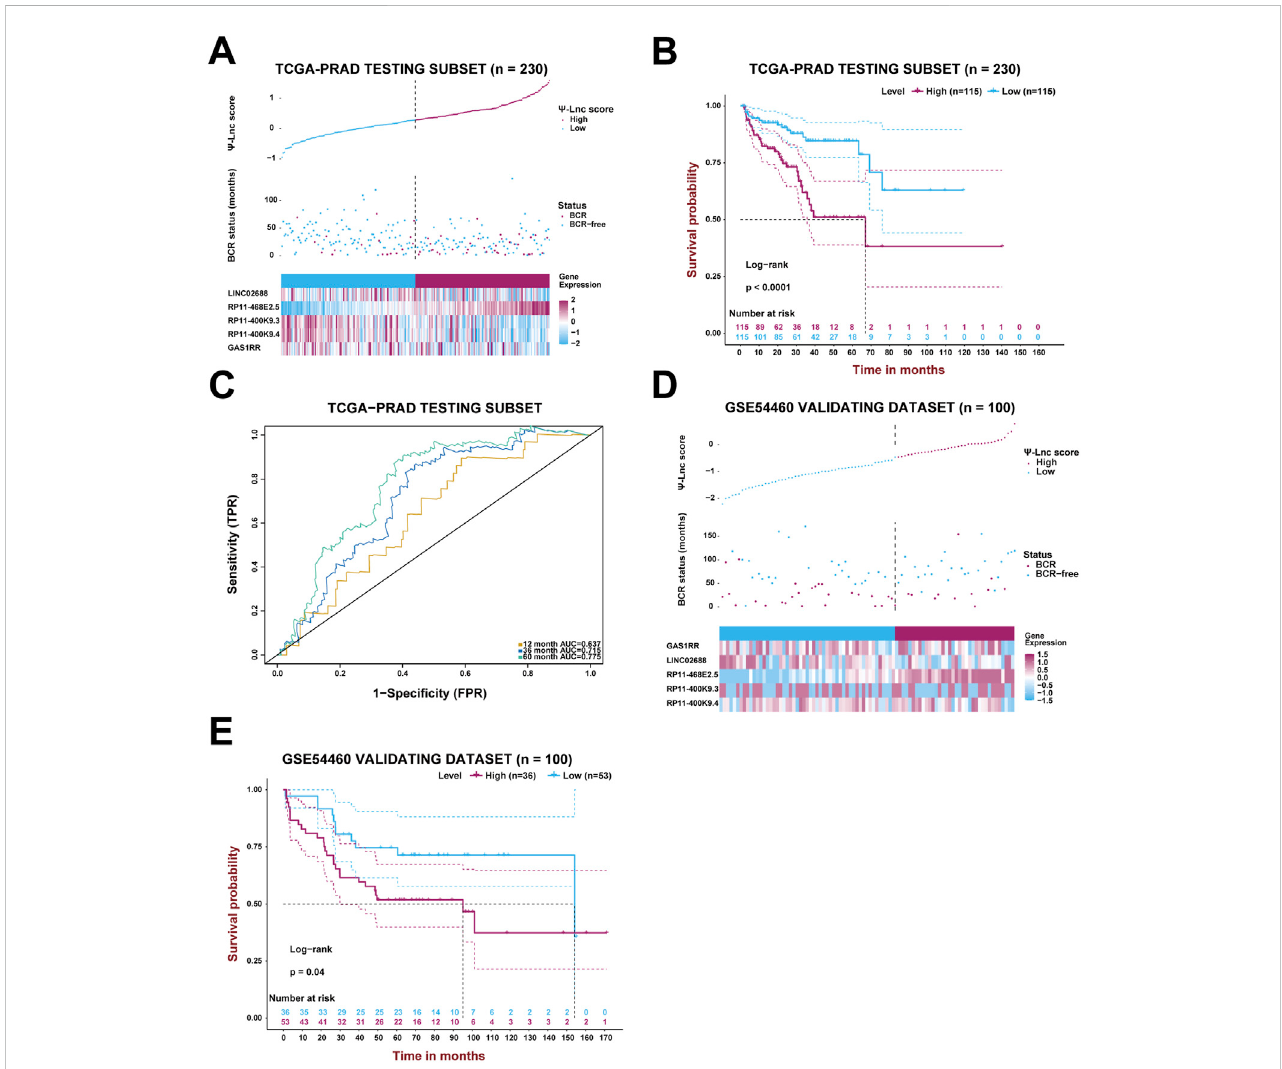
FIGURE 4 Validation of the prognostic model with Ψ -related lncRNAs. (A) The PCa patients ’ pro fi les on three aspects, Ψ -lnc score, BCR status, and the fi ve genes ’ expression levels, in the TCGA testing subset. (B) The Kaplan-Meier BCR survival analysis between two Ψ -lnc score subgroups in the testing subset. (C) The ROCcurvesshowtheaccuracyofthe Ψ -lncscoreinpredictingBCR-freesurvival. (D) ThePCapatients ’ pro fi lesonthreeaspects, Ψ -lncscore,BCRstatus,and the fi ve genes ’ expression levels, in the GSE54460 validating dataset. (E) The Kaplan-Meier BCR survival analysis between two Ψ -lnc score subgroups in the GSE54460 validating